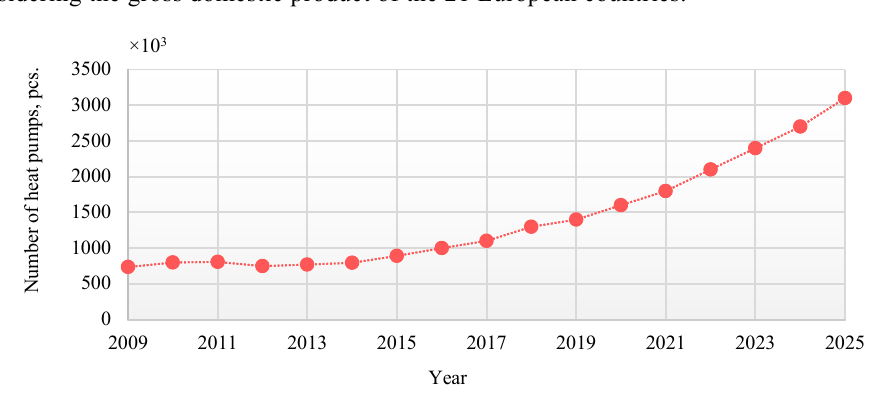
Fig. 13. Forecast of the heat pump market development until